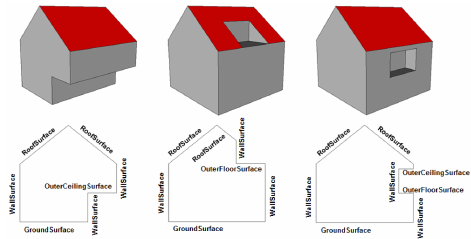
Figure 7. Buildings components in CityGML shell model.